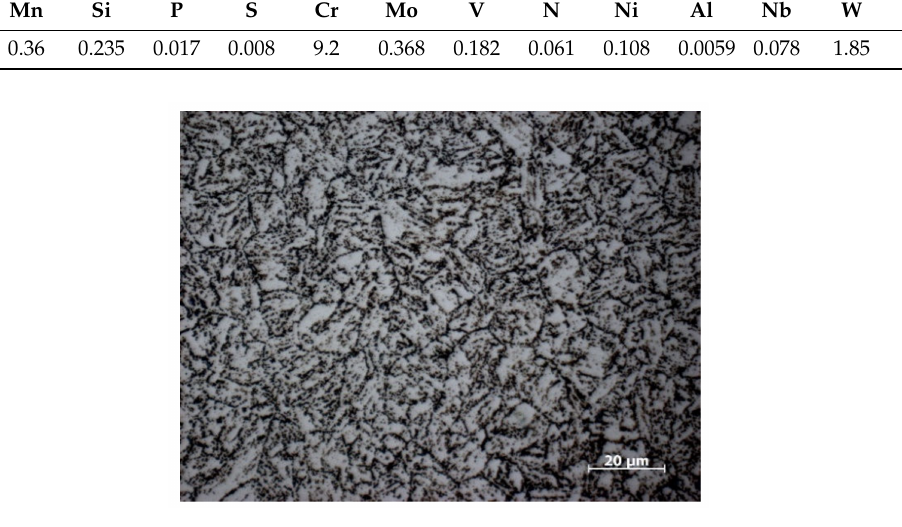
Figure 1. Optical micrograph of the investigated P92